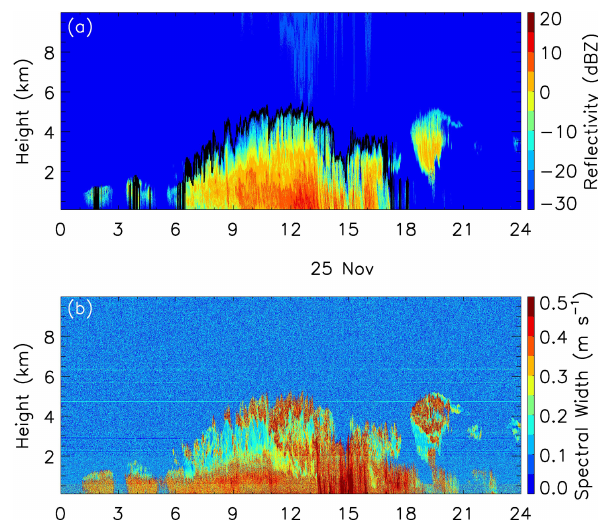
Figure 2. Height–time cross section of (a) radar reflectivity and (b) Doppler spectral width for observations on 25 November 2017. The cloud top for snow clouds (surface radar reflectivity greater than − 20dBZ) is also shown in (a)